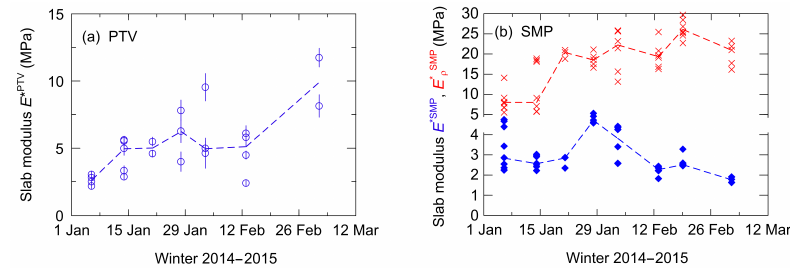
Figure 3. Effective elastic modulus of the slab derived from (a) the bending of the slab via PTV analysis with vertical lines denoting measurement uncertainty ( N = 23) and (b) the SMP signal analysis ( N = 48), either directly E *SMP (solid blue triangles) or via density E *SMP ρ (red crosses). Dashed lines connect the median values per